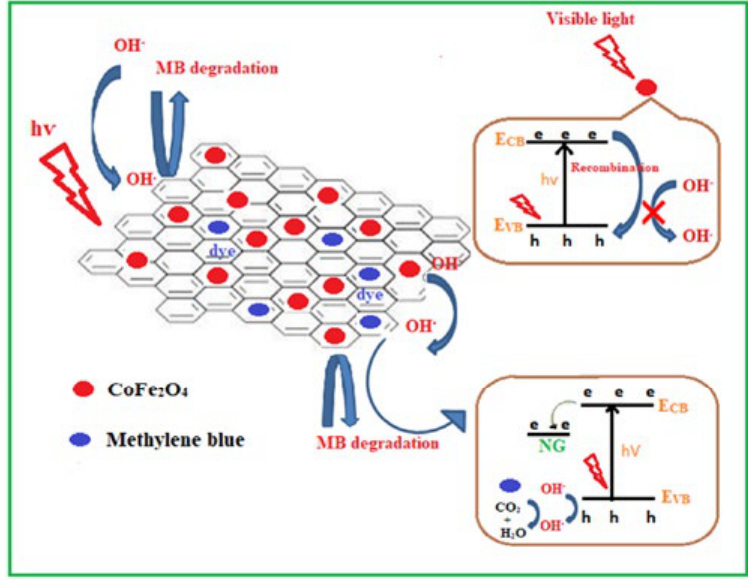
Fig. 12: Plausible mechanism for the photodegradation of MB by NG@CoFe Fig. 12 Plausible mechanism for the photodegradation of MB by NG@CoFe 2 O 4